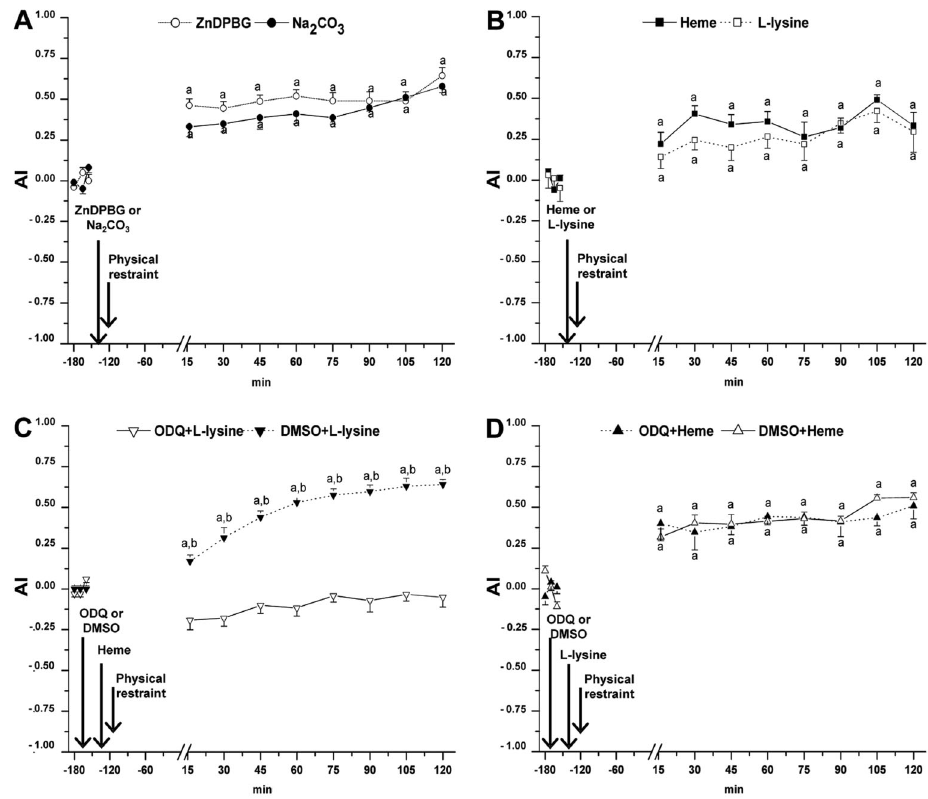
Figure 1. Antinociceptive index (AI) in the tail-flick test in rats. A , Administration ( icv ) of ZnDPBG (200 nmol/4 m L, HO inhibitor) or vehicle (Na 2 CO 3 ). B , Administration ( icv ) of HO substrate heme-lysinate (Heme, 150 nmol/4 m L) or vehicle (L-lysine) on AI. C , Effect of icv injection of soluble guanylyl cyclase inhibitor (ODQ, 5.2 nmol/4 m L) or vehicle (1% DMSO) followed 30 min later by L-lysine on AI in the tail flick test. D , Treatment ( icv ) of soluble guanylyl cyclase inhibitor (ODQ, 5.2 nmol/4 m L) or vehicle (1% DMSO) followed 30 min later by heme-lysinate (150 nmol/4 m L) on AI in the tail flick test. Data are reported as means AI (±SE), n=8 in each group. a : P , 0.05, compared with respective control period; b: P , 0.05, ODQ++L-lysine group compared with DMSO++L-lysine group (Newman-Keuls test). The AI of the ODQ++L-lysine group did not differ over time when compared with the AI of the control period ( C